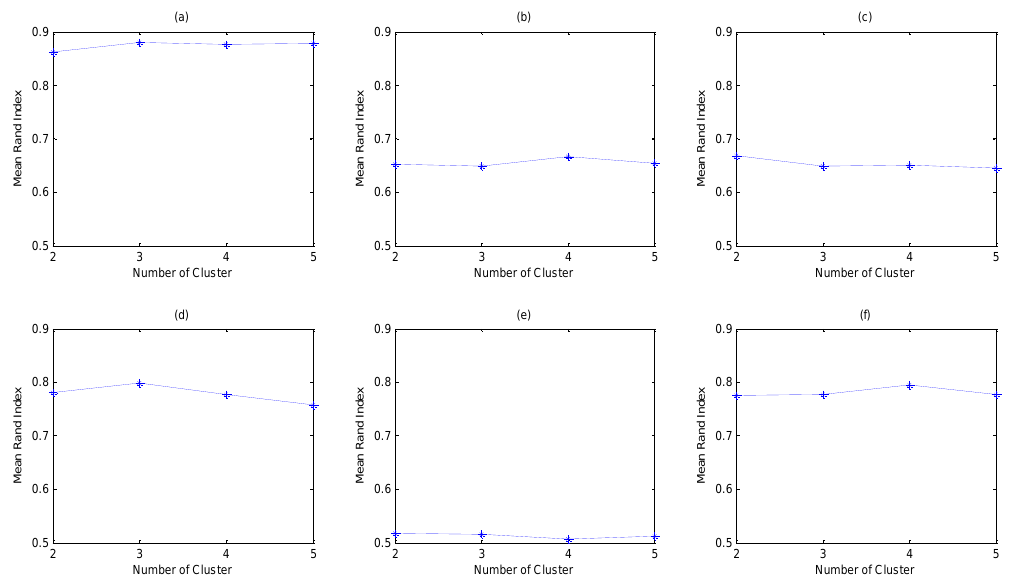
Figure 7. Clustering results of unweighted- SD method versus number of groups, G , for UCI datasets: (a) Soybean, (b) Heart, (c) Ionosphere, (d) Wine, (e) Sonar, and (f) Iris.